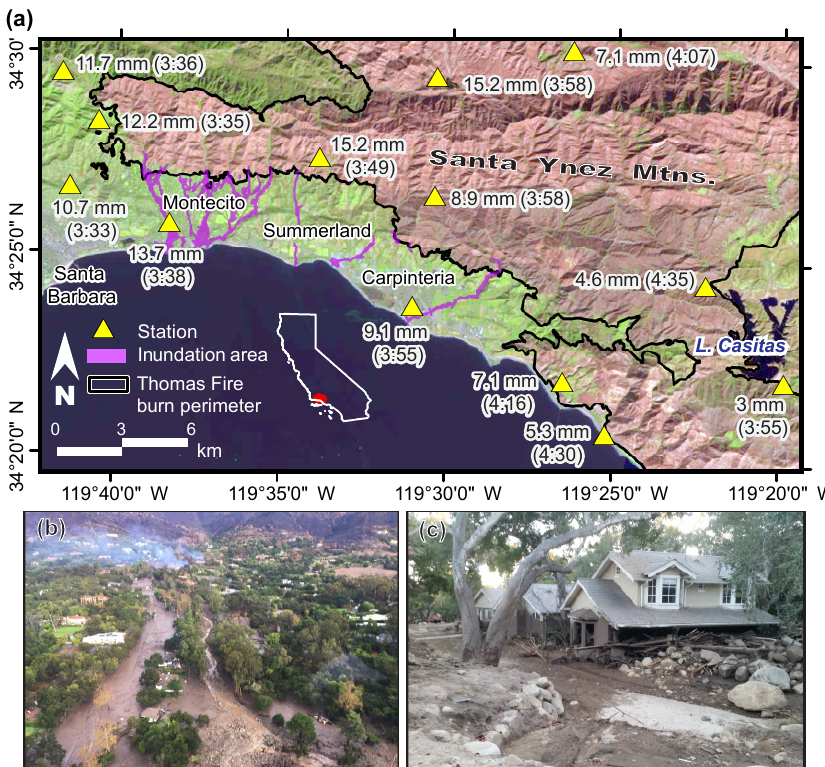
Figure 1. (a) Burned areas within the perimeter of the Thomas Fire are depicted in red and unburned areas in green, as derived from the Landsat 8 thermal infrared sensor and surface reflectance imagery (USGS, 2018b). Inundated areas, as mapped by the California Geological Survey, are displayed in purple. Station-based observations of the greatest 5min event precipitation and the start time of the interval (LST) are labeled. (b) Aerial photo of San Ysidro Creek in Montecito following the debris flow; areas that were once roads and homes appear as rivers of mud and debris. Photo: Ventura County Air Unit. (c) A home destroyed in the debris flow. Photo: Brian Swanson,